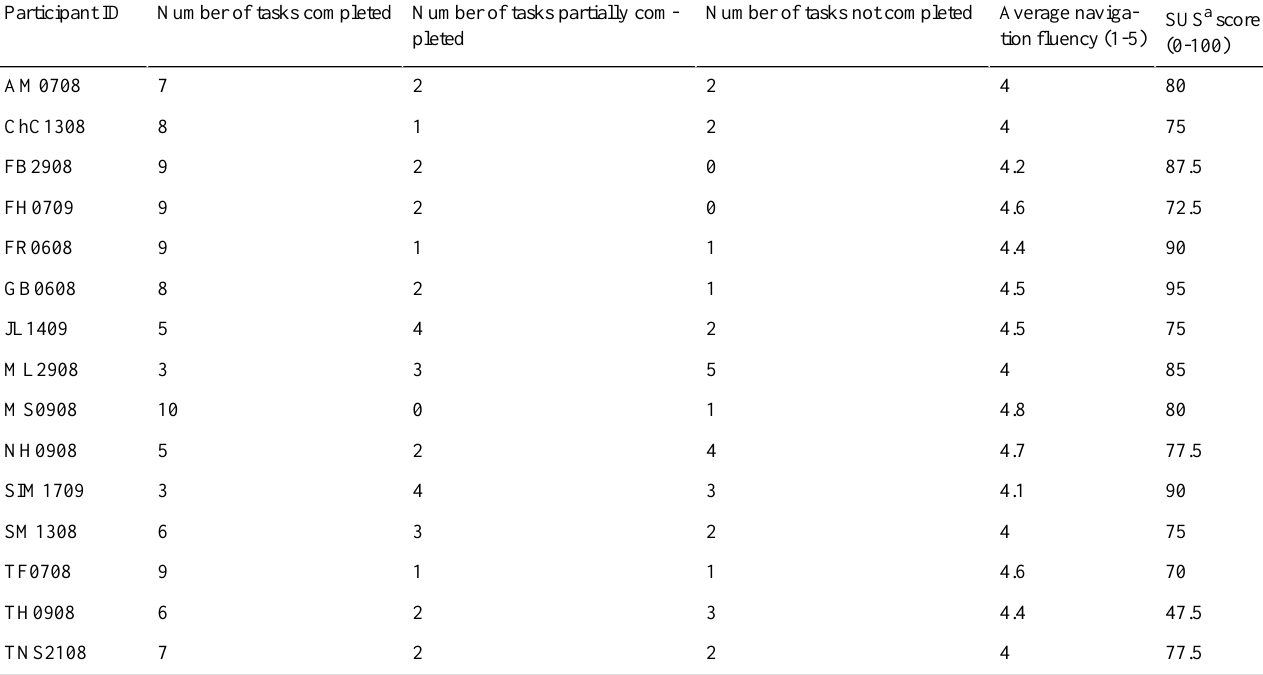
Table 3. Individual assessments of the 11